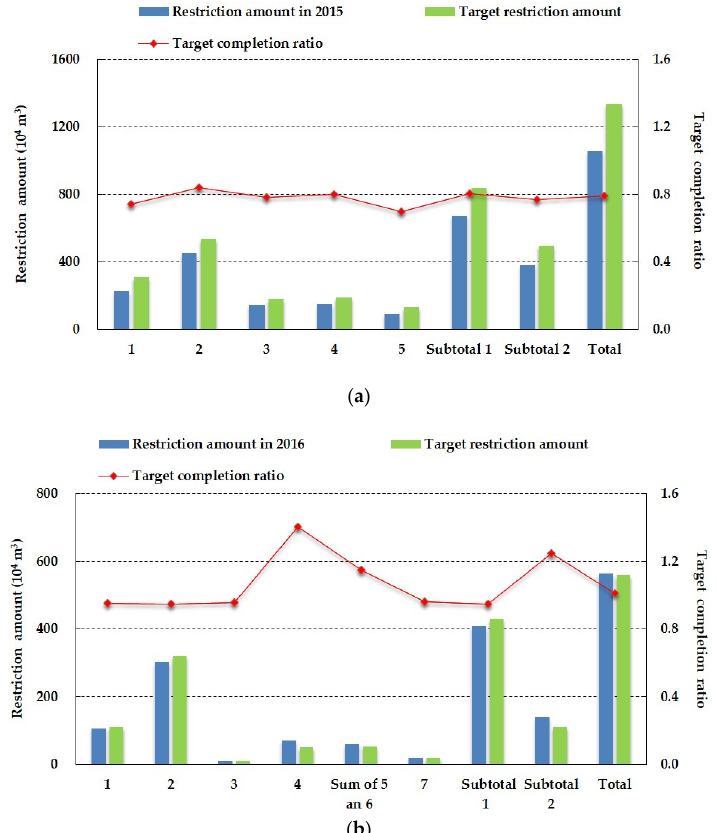
Figure 6. The restriction amount of agricultural groundwater exploitation in the project regions in 2015 ( a ) and 2016 ( b ) of Quzhou County. Restriction amount means the restriction amount of agricultural groundwater exploitation under normal flow conditions in evaluation baseline years (2015/2016); Sum of 5 and 6 mean the total amount of project 5 and project 6; Subtotal 1 represents the total restriction amount of the water conservancy projects; Subtotal 2 means the total restriction amount of the agricultural projects; the project numbers are the same as mentioned